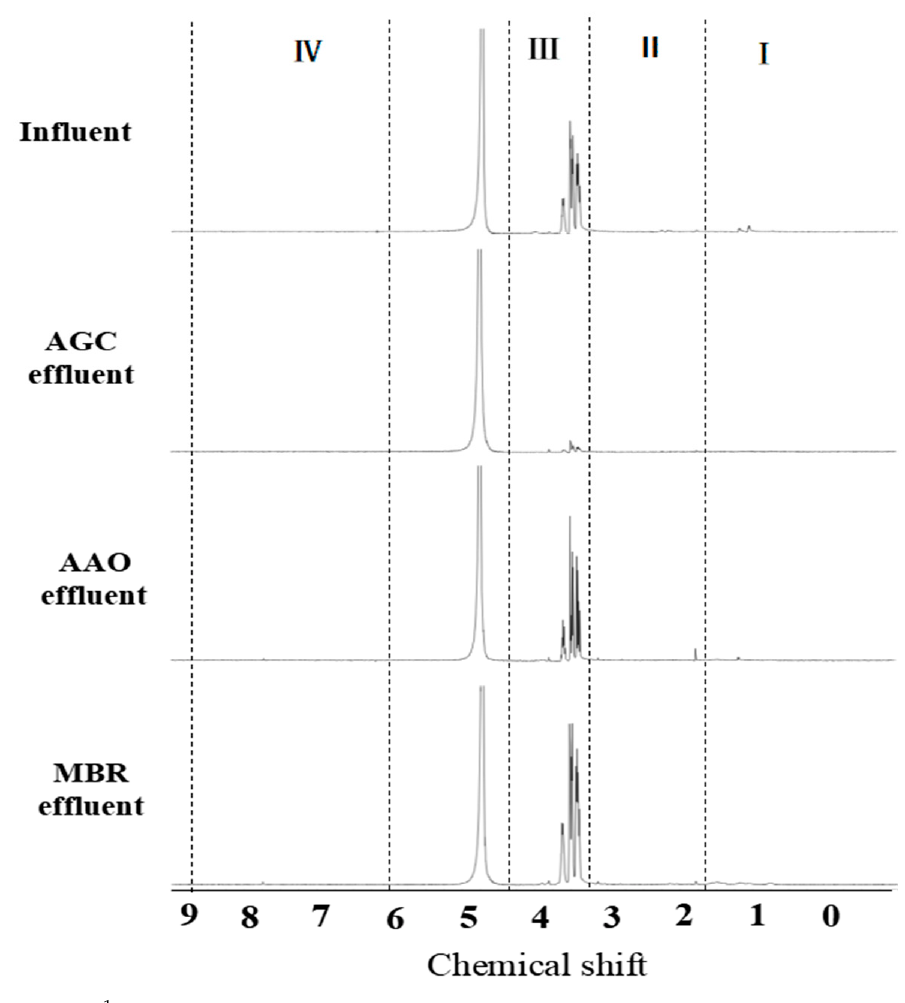
Figure 4. 1 H-NMR spectra of the WWTP.